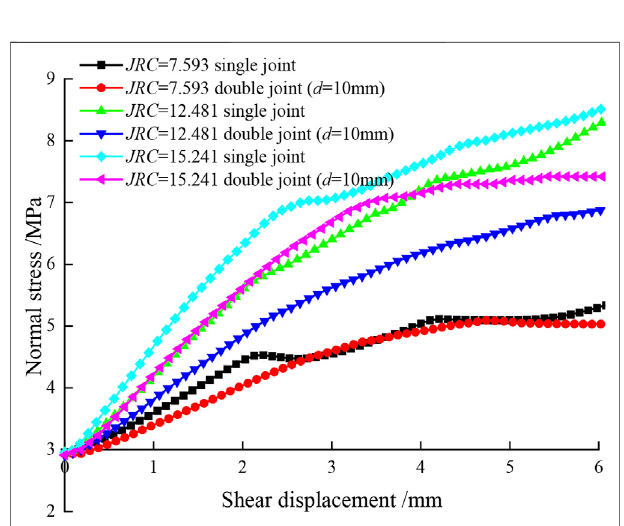
FIGURE 8 | Shear displacement and SRI relation of single- and double- joint specimens.